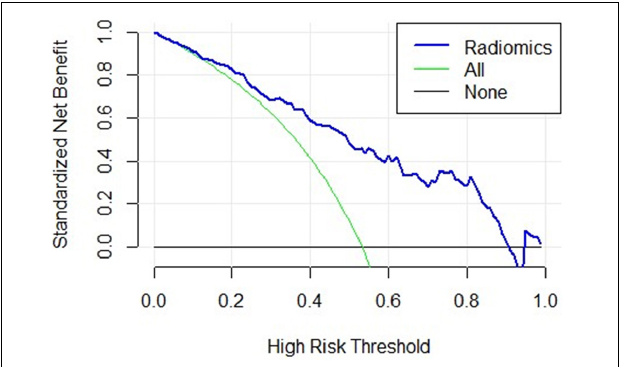
FIGURE 4 | The decision curve of the radiomics signature. The x -axis represents the threshold probability, the y -axis represents the net benefit, the green curve represents the hypothesis that all patients were in the PD class, the black curve parallel to the x -axis represents the hypothesis that all patients were in the control class. The blue curve represents the threshold of 0.1–0.9, where the radiomics signature gains more benefit than treating all the patients or where no one was